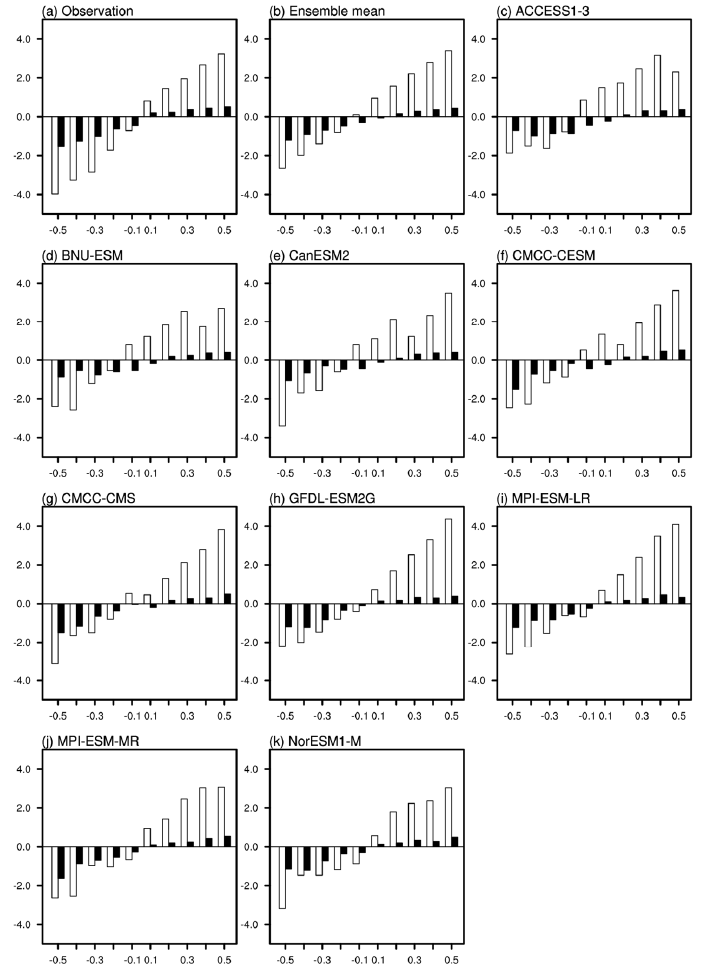
Figure 5. Changes in the frequency of cold surge occurrences (yr −1 ) with changes in the criteria for the identification of cold surges (the temperature drop criterion is shown in the white bar and the temperature anomaly criterion is shown in the black bar). The horizontal axis is divided by the standard deviation of the winter daily SAT anomaly.